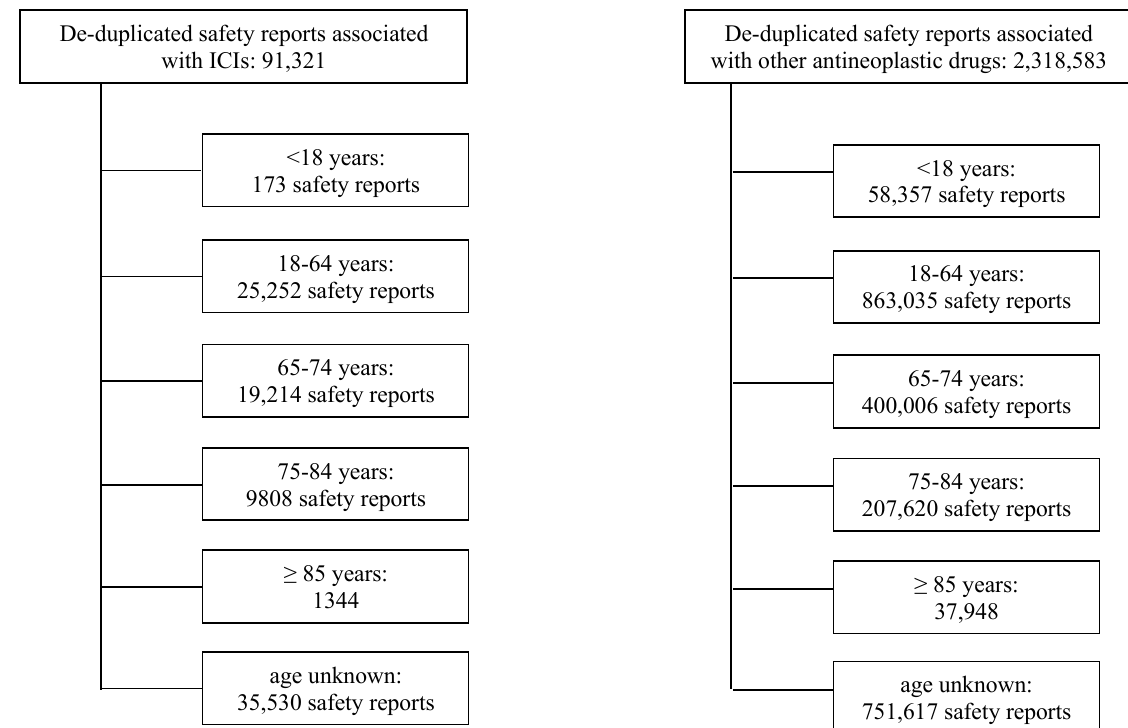
Figure 1. Selection of safety reports associated with either immune checkpoint inhibitors or other antineoplastic drugs, collected in VigiBase from database inception to 30 August 2020. Abbreviations: ICI, immune checkpoint inhibitor.